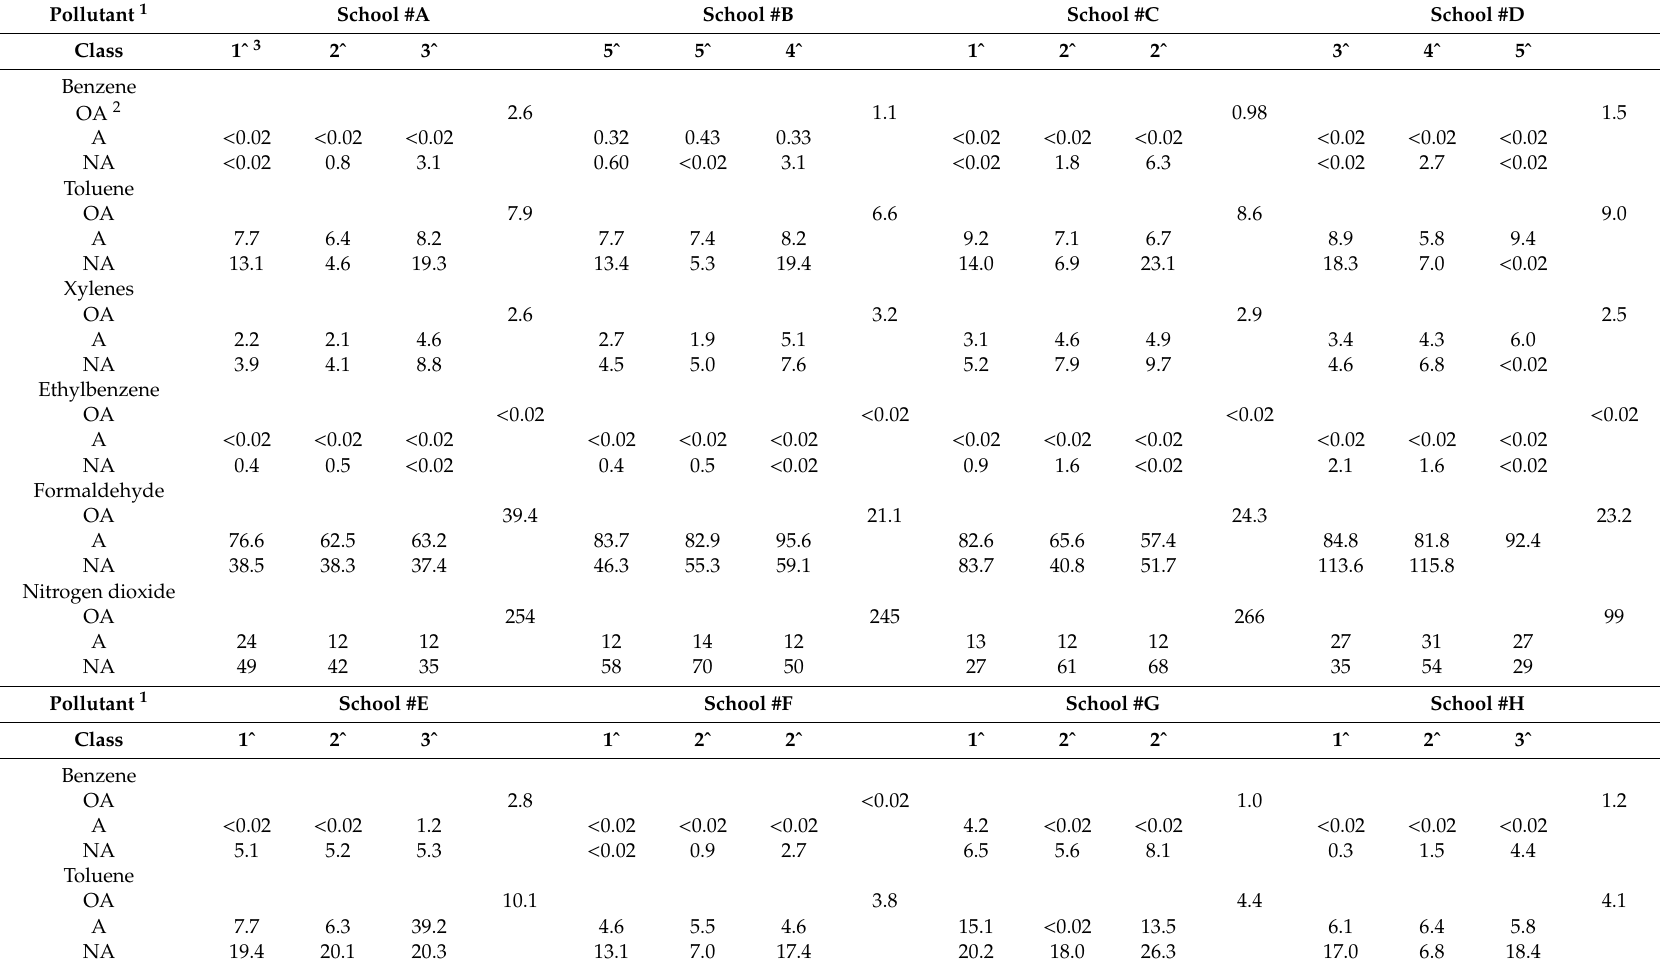
Table 3. Indoor and outdoor levels ( µ g m − 3 ) of gaseous pollutants sampled by denuders in eight schools in downtown Rome. Pollutant